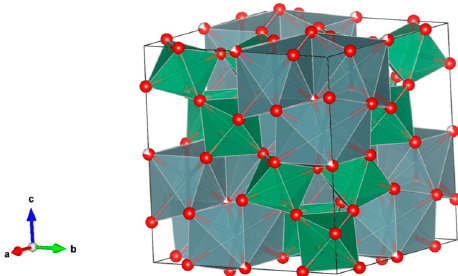
Figure 3. Pyrochlore. A 2 B 2 O 7 . Structure cubic, Sp. gr. Fd3m. A-site-cations can be Na, Ca, Y,